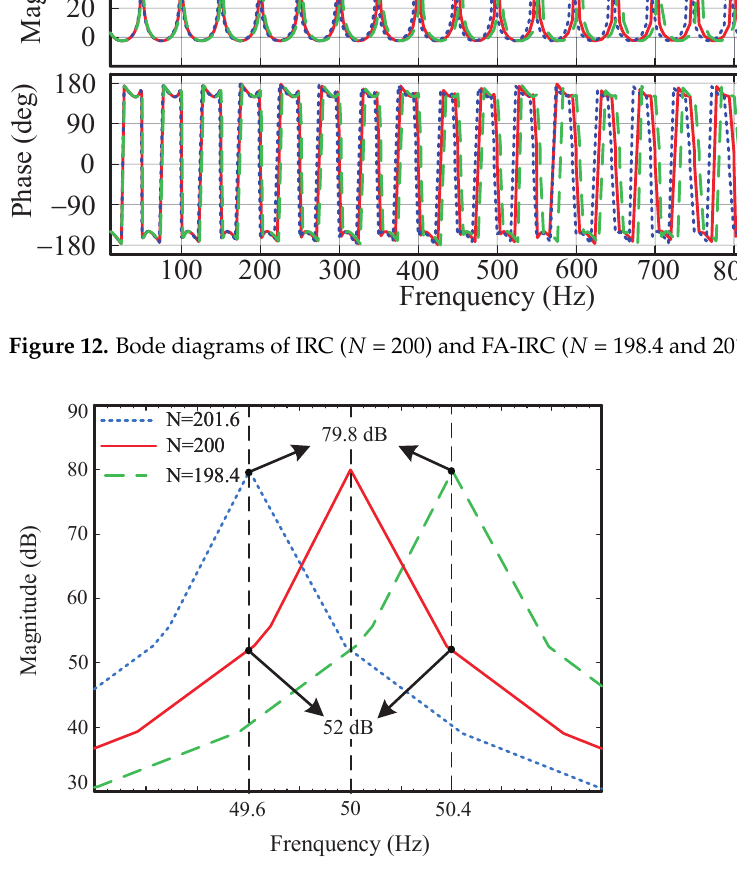
Figure 13. Magnitude characteristics of IRC ( N = 200) and FA-IRC ( N = 198.4 and 201.6) at the fundamental